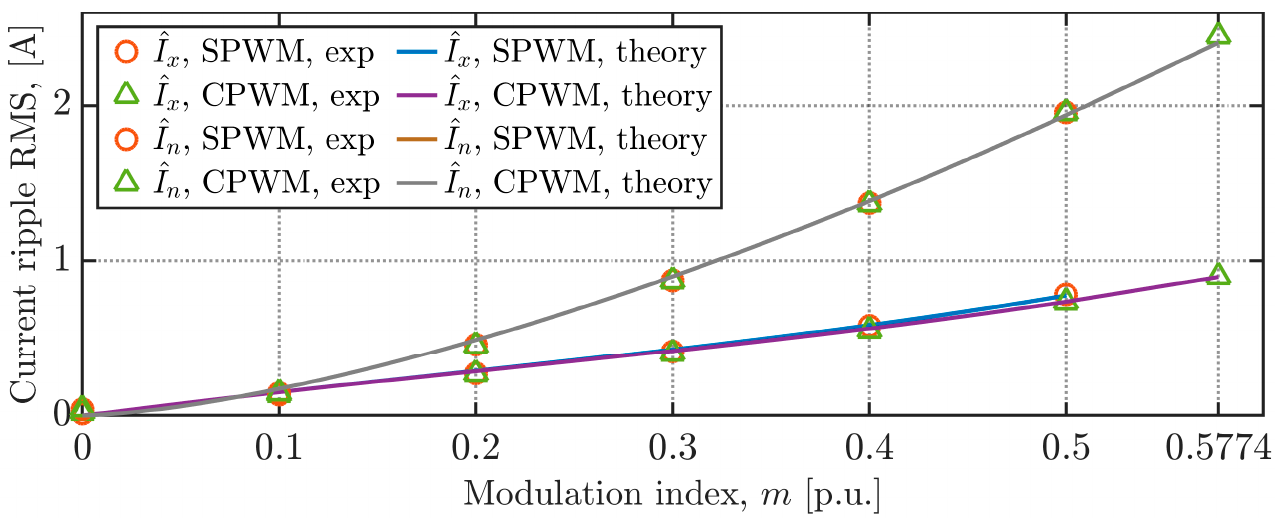
Figure 18. Normalized RMS value of phase and neutral switching current ripple in case of SPWM and CPWM.